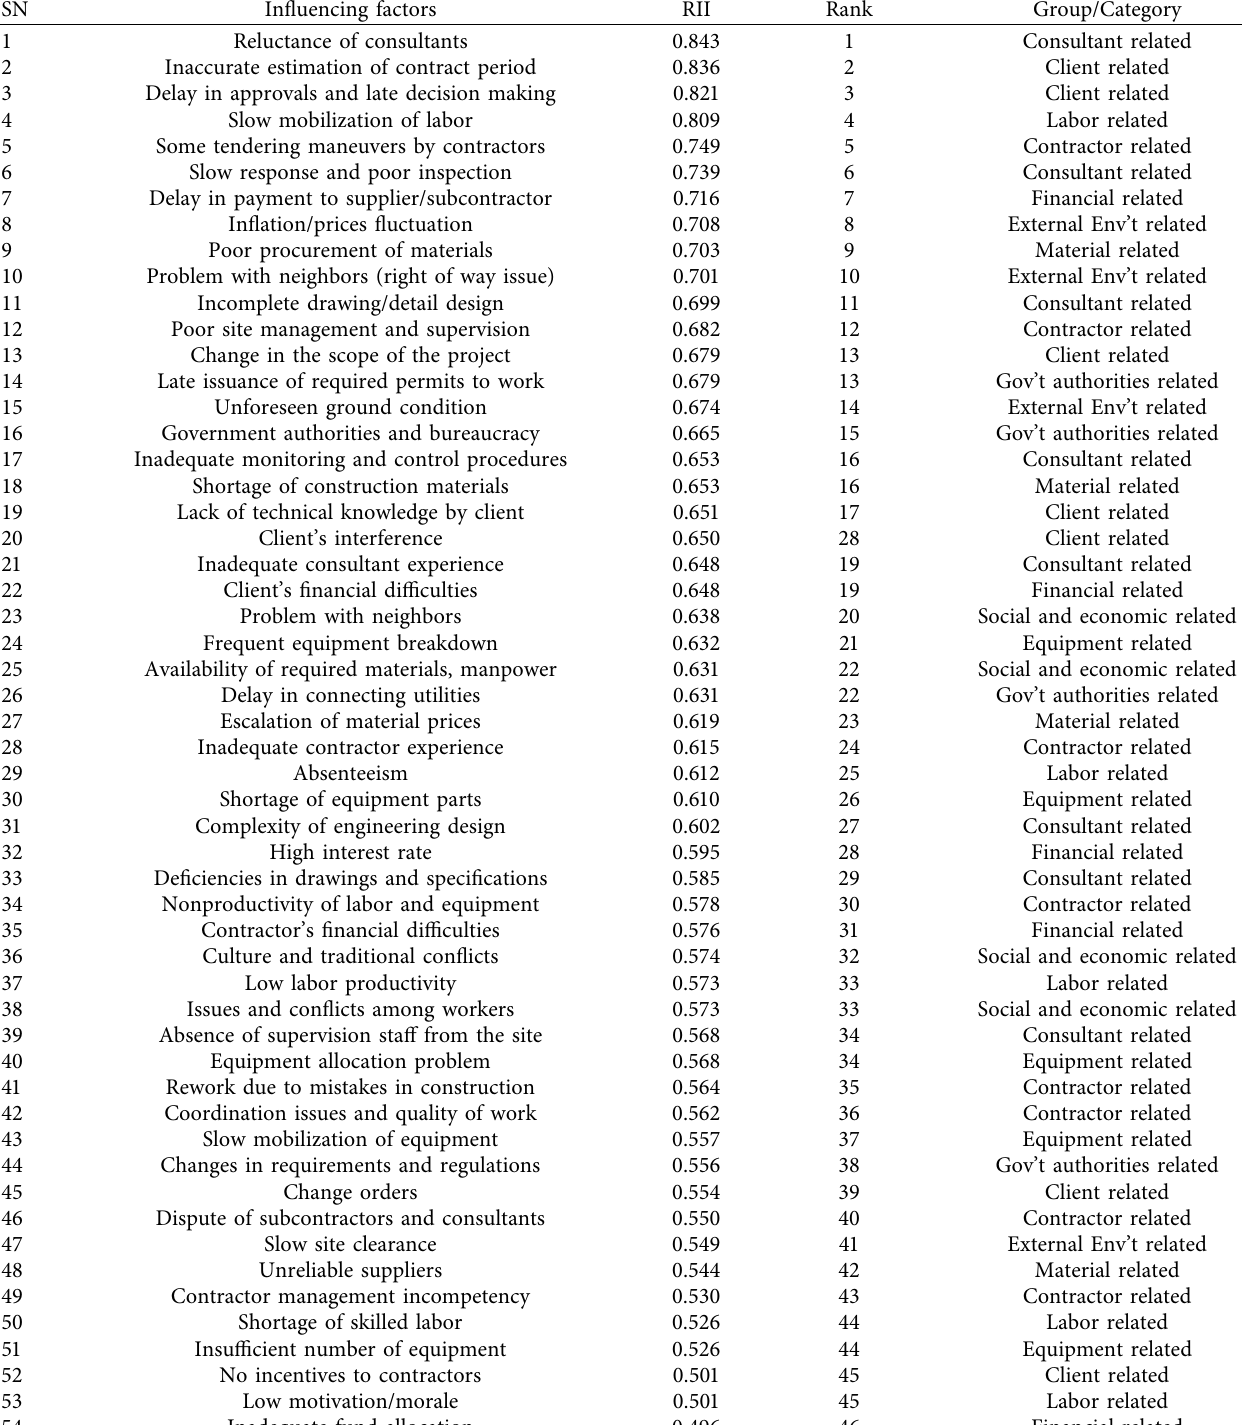
Table 4: The overall ranking of the